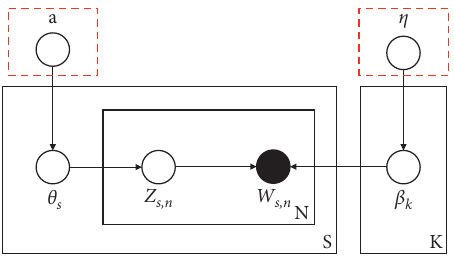
Figure 1: The Bayesian networks of the LDA.